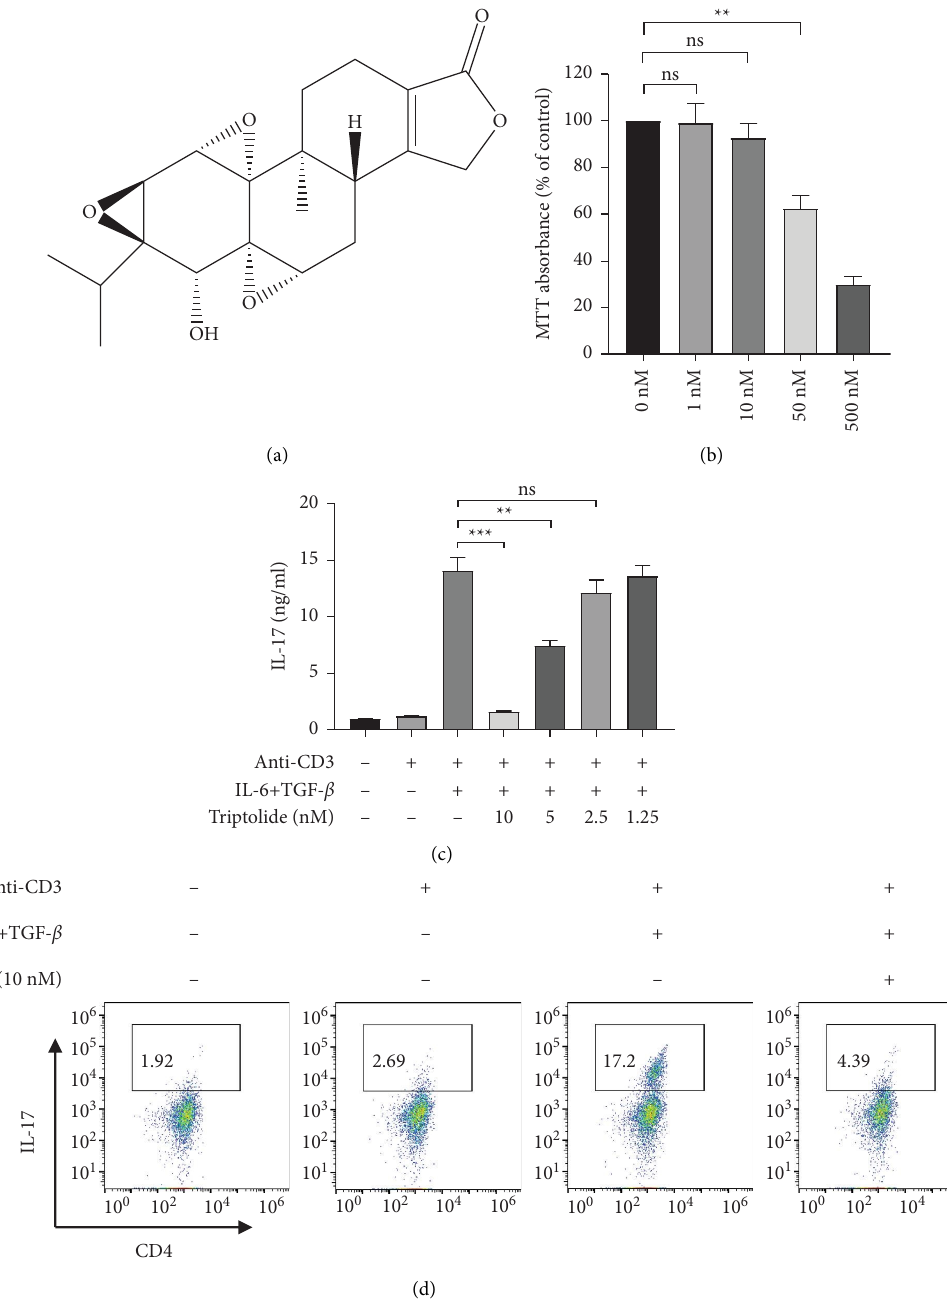
Figure 1: Te efects of triptolide on cell viability and IL-17 diferentiation. (a) Triptolide chemical structure. (b) MTT assay conducted to detect the viability of splenocytes which were isolated from mice in the presence or absence of increasing dosages of triptolide (1–500 nM) treatment. (c) Anti-CD3 or anti-CD3 + IL-6 + TGF- β used to stimulate the isolated splenocytes from mouse models with or without 1.25–10 nM triptolide treatment. ELISA was used for measuring IL-17 concentration in the supernatants. (d) IL-17 + CD4 + T population determined by fow cytometry analysis. Each bar presents the mean ± standard deviation obtained from three to four separate experiments. ∗∗ P < 0 . 01, ∗∗∗ P < 0 . 001 compared to the model group. n.s indicates no